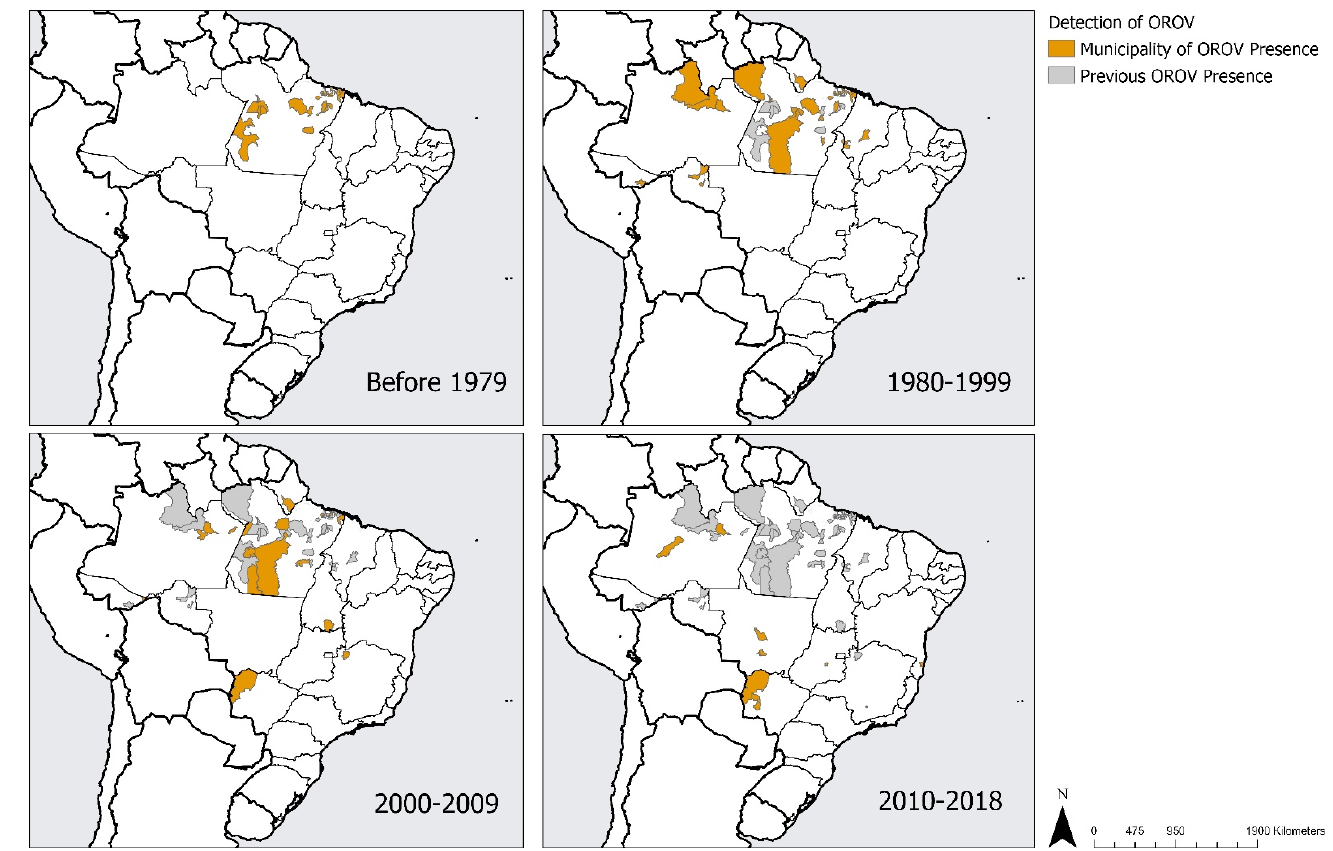
Figure 4. Documented presence of Oropouche virus by 10 years period, Brazil, 1960 to 2018.